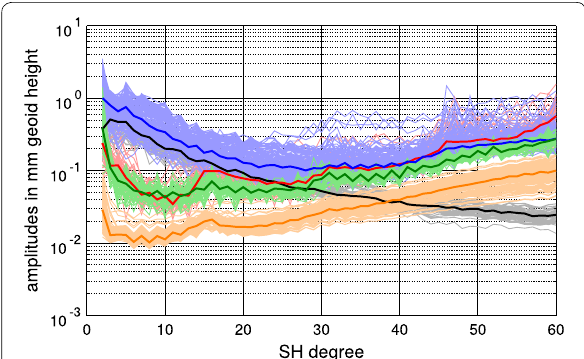
Fig. 1 Degree amplitudes in terms of geoid height error for 4 years: simulated GRACE errors (red), formal GRACE GFZ RL06 errors (orange), empirical GRACE errors (green). The grey lines represent the true input signals whereas the blue lines represent the estimated GRACE GFZ RL06 coefficients. The medians of the monthly solutions are shown as bold